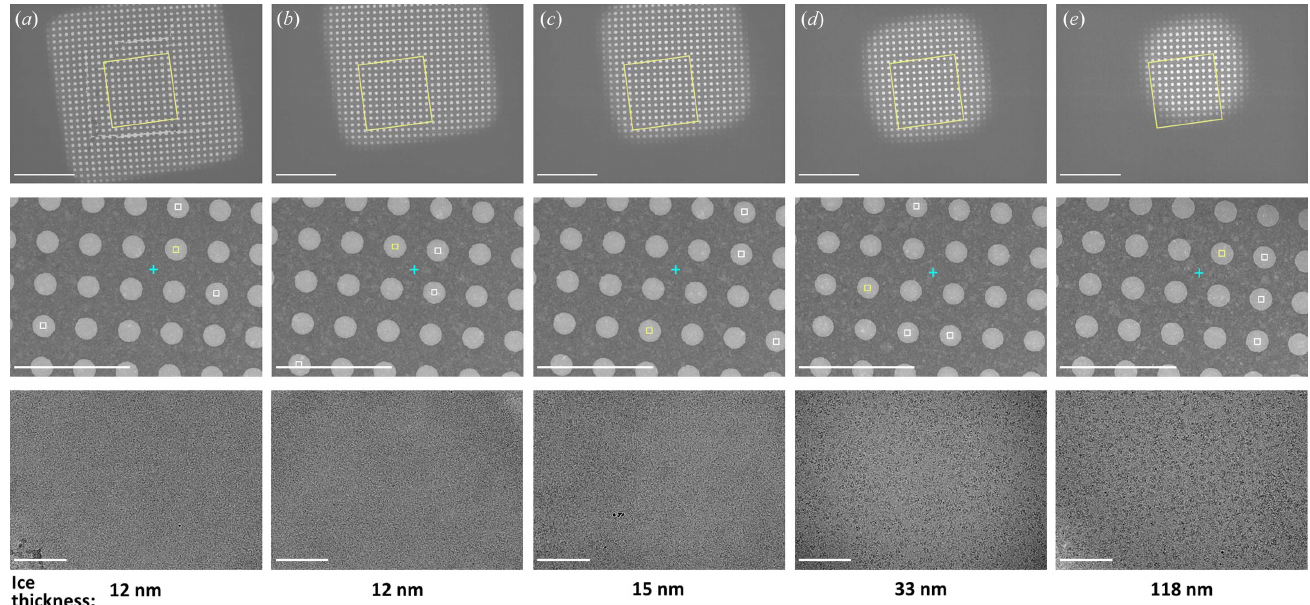
Figure 5 Real-world Smart Leginon screening MSI grid analysis of a user grid. The MSI analysis, with square magnification images of several squares from Grid 3 in Fig. S15 in the first row, hole magnification images of corresponding holes in the second row, exposure magnification images from inside corresponding holes in the third row, and ice thickness estimations in the fourth row, allowed the operator and user to determine that medium-sized squares contain 30– 40 nm-thick ice containing ( d ) non-overlapping particles of interest, while ( a )–( c ) squares with ice thinner than 30 nm ice were void of particles and ( e ) squares with ice on the order of 100 nm thick had overlapping particles. Scale bars are 10 m m for the first row, 5 m m for the second row and 100 nm for the third